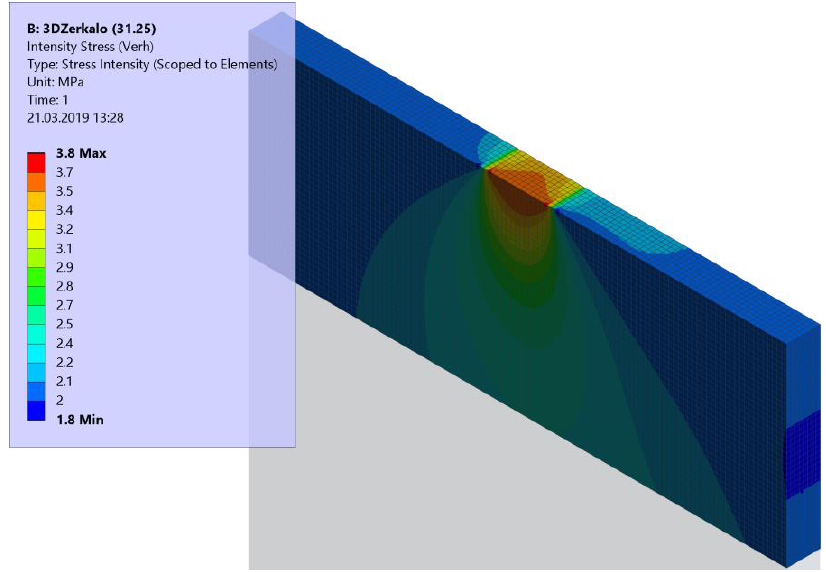
Fig. 6. Distribution of stress intensity σ i in the upper part of the deep beam The value of σ i on the top surface of the deep beam in the load application area q f